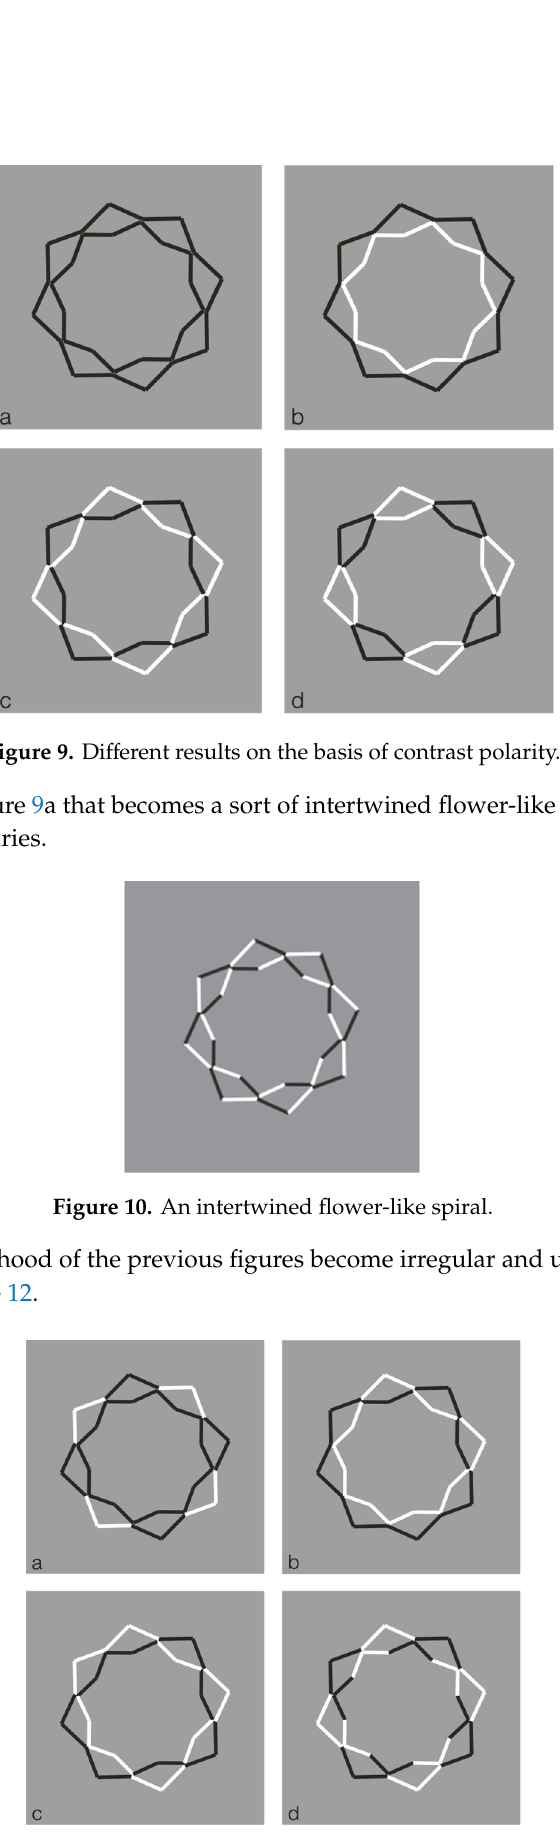
Figure 11. Iregular shapes from contrast polarity.